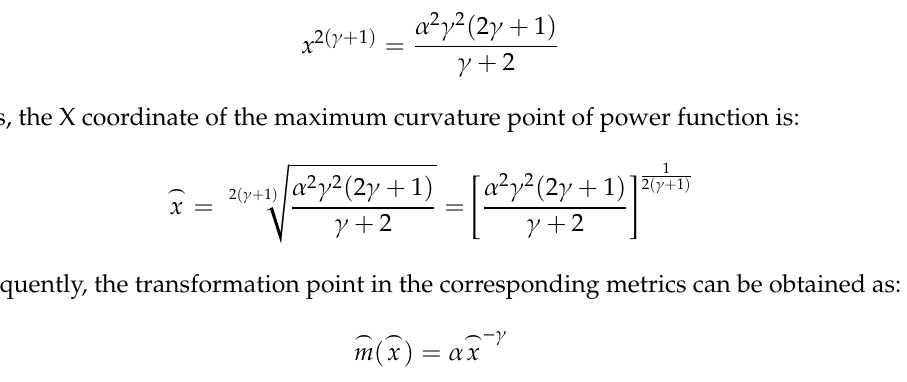
Figure 3. The image of y = x − 2 and its transformation point with the maximal curvature. Therefore, this study chooses the value value for evaluating whether each entity in the metric is defect-free or